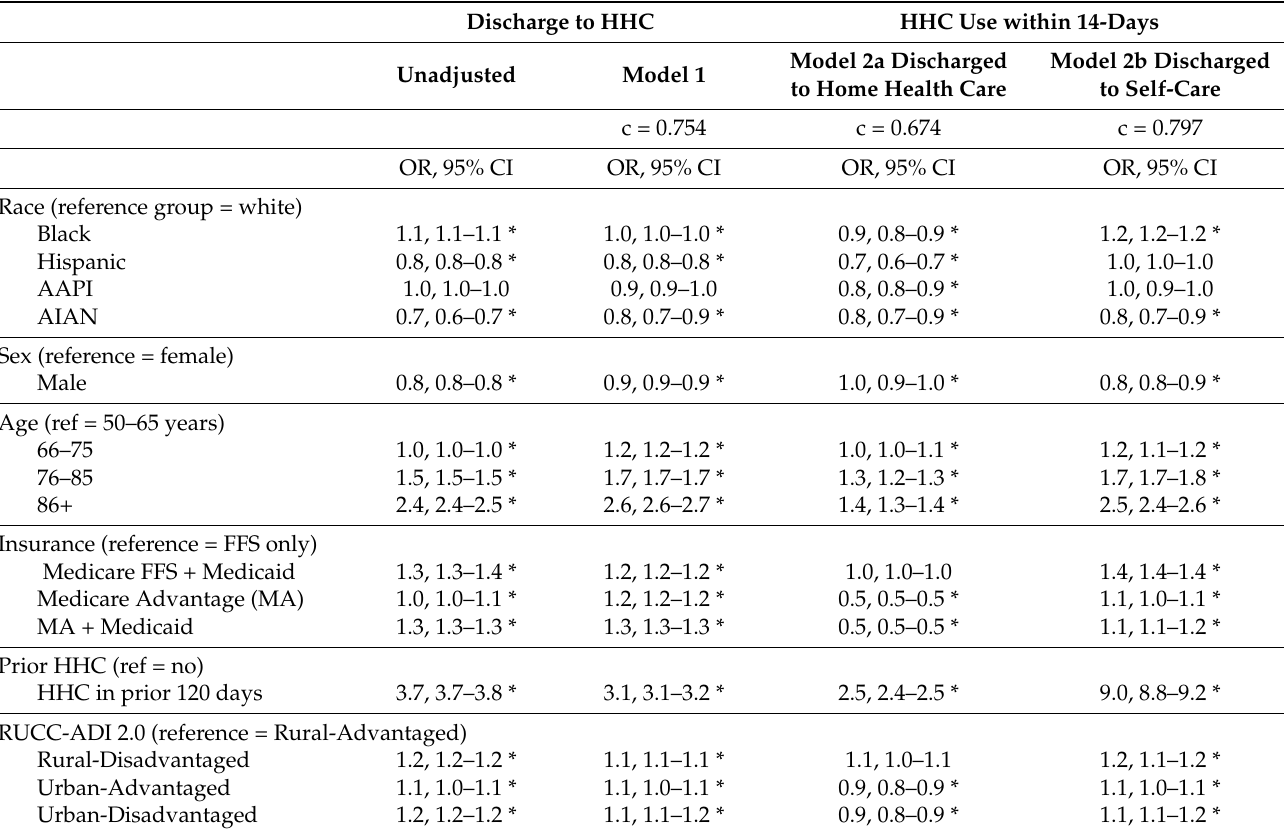
Table 3. Logistic models predicting hospital discharge to home health care (HHC) and use of HHC within